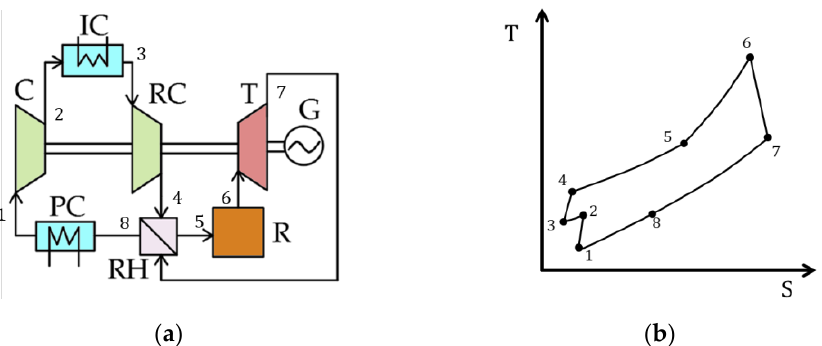
Figure 4. Supercritical CO 2 Brayton cycle with precooling: ( a ) schematic diagram; ( b ) T – S diagram [12]. R — reactor; T – turbine; G — generator; RH — regenerative heat exchanger; PC — precooler; IC — internal cooler; C — compressor; RC — high-pressure compressor.